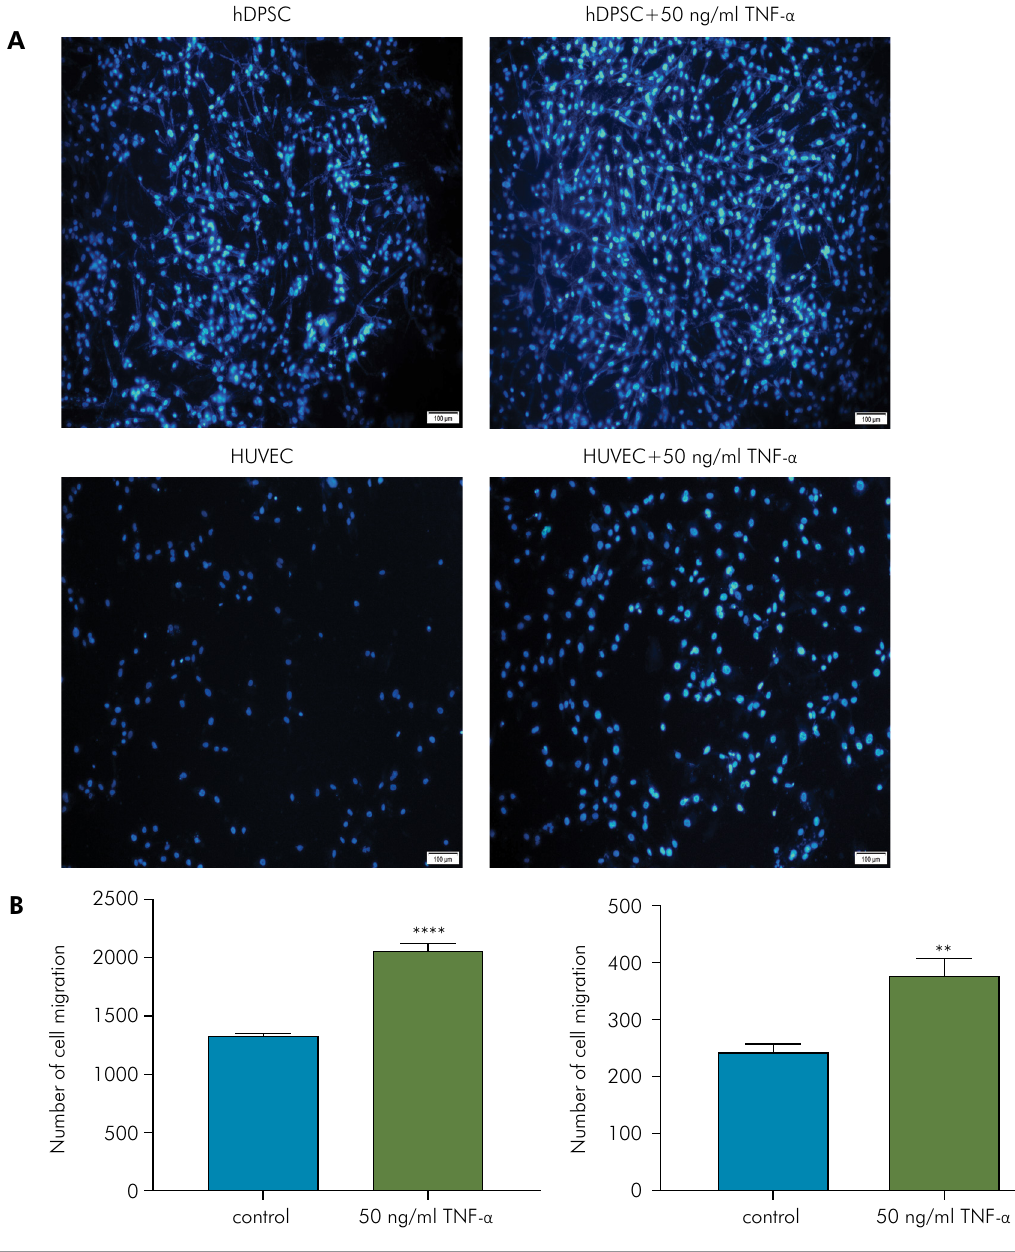
Figure 4. TNF- α enhanced the migration abilities of hDPSCs and HUVECs. (A) The numbers of migrated cells with 50 ng/ml TNF- α and control incubation for 24 h were compared using the transwell assay. Photographs show DAPI-stained cells from two wells from three different experiments that migrated to the lower surface; five random fields per well were counted. (B) Mean numbers of hDPSCs and HUVECs that migrated in response to TNF- α (50 ng/ml), determined by cell counting at 100× magnification (**p < 0.01; ****p < 0.0001 vs.